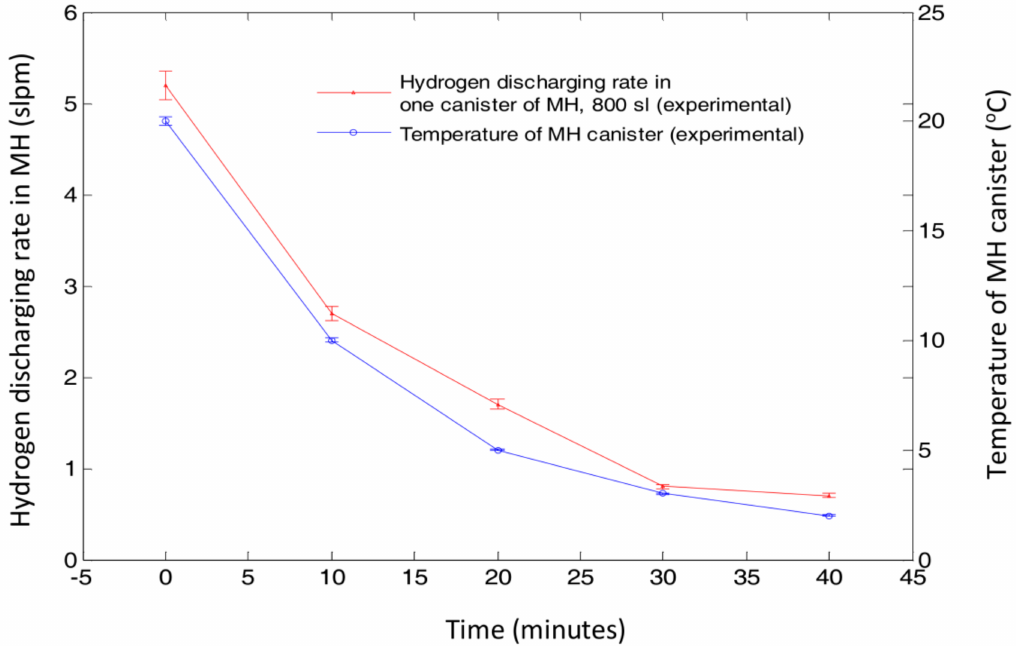
Figure 9. Hydrogen discharge rate in MH canister (MmNiMnCo, 800 sl) and the temperature of the MH canister as a function of discharging time (experimental); maximum 1% error is associated with the data for flow rate and 1% error associated with